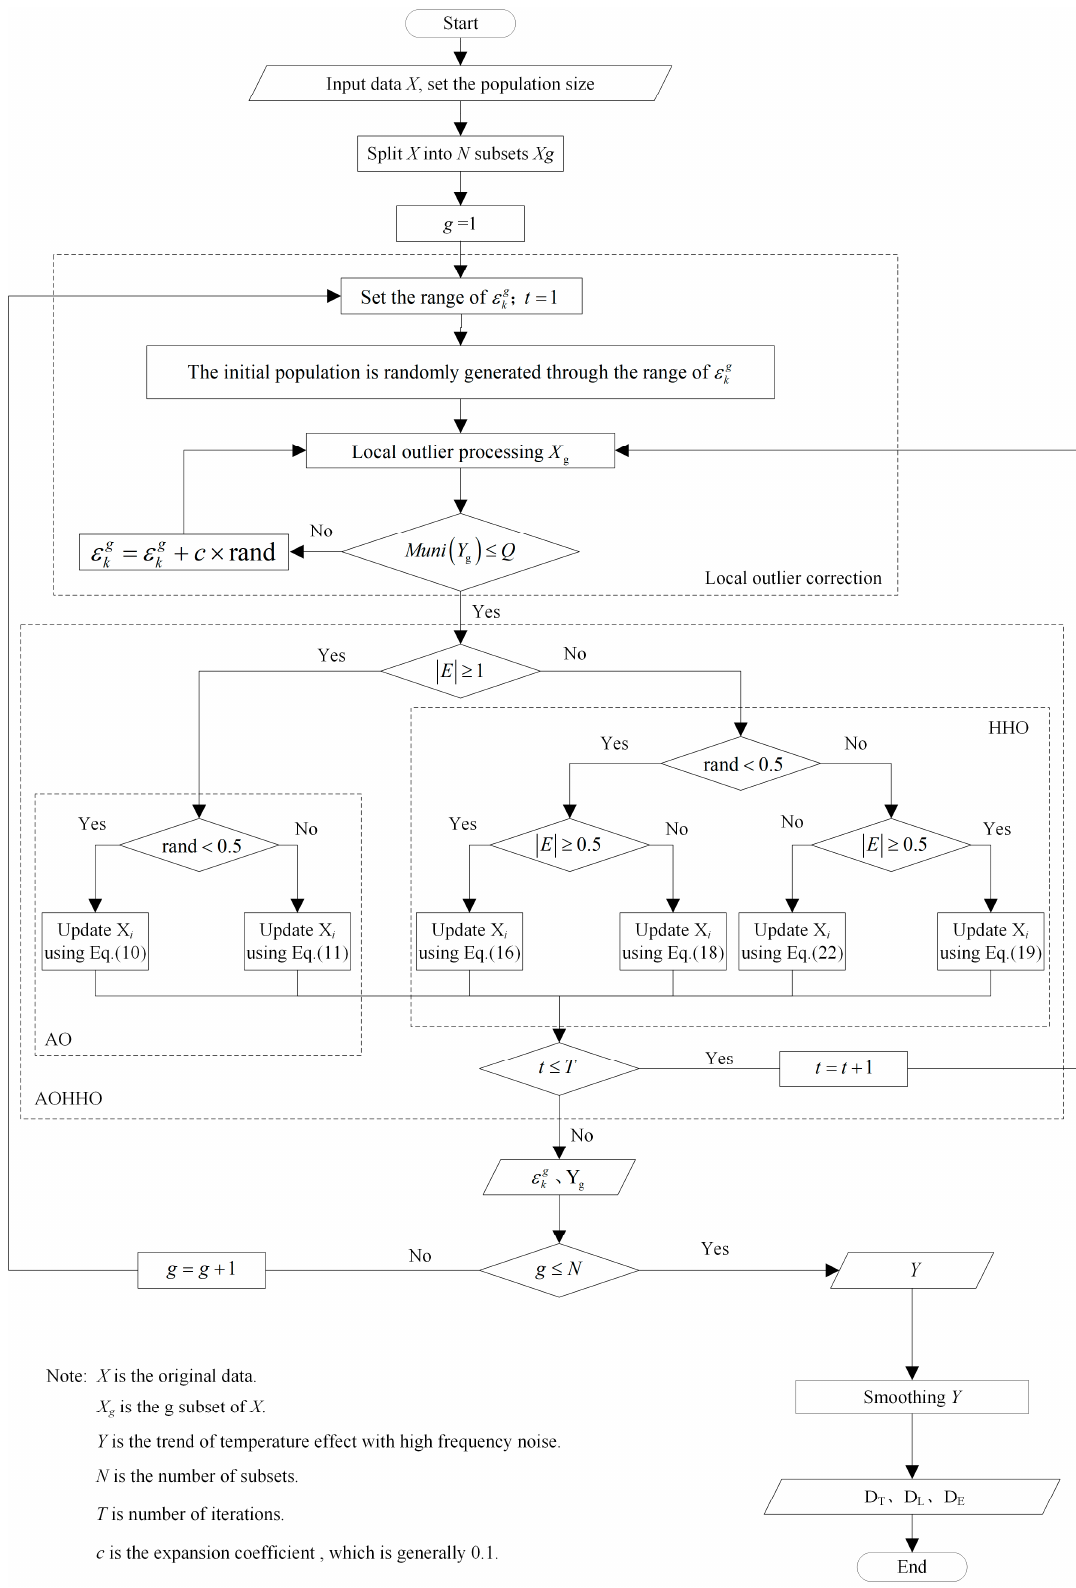
Figure 5. Flow chart of the proposed method.